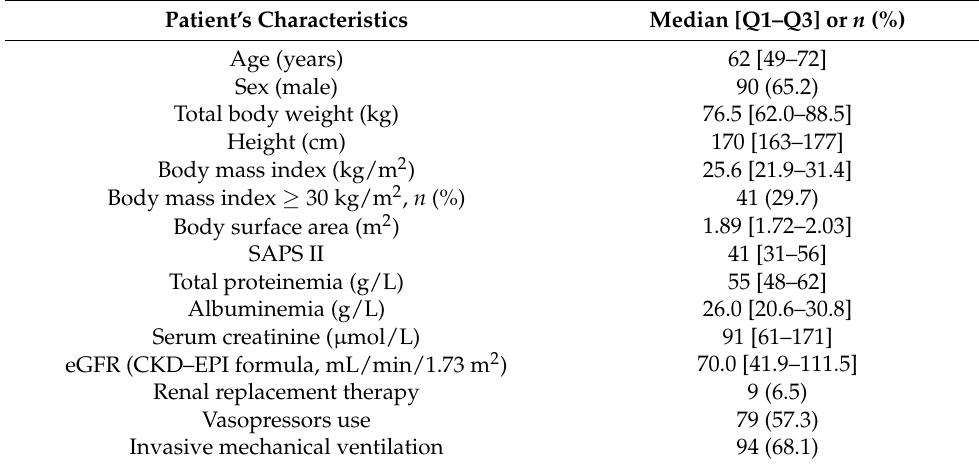
Table 1. Patient’s